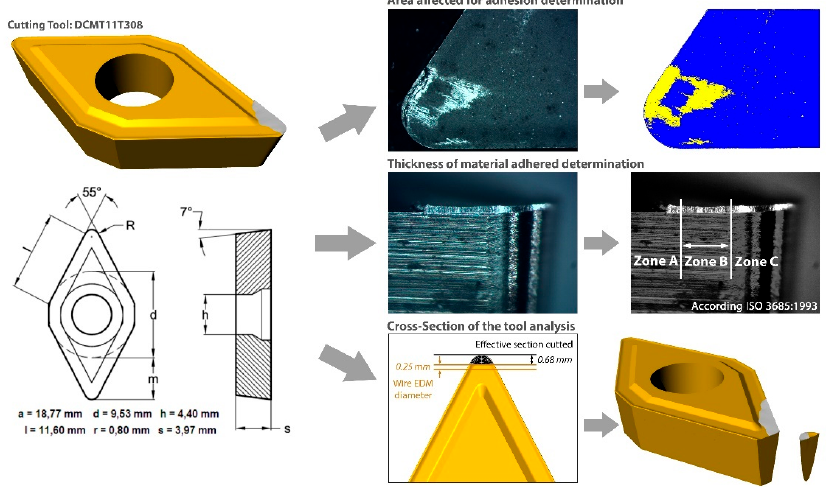
Figure 2. Experimental proposal for adhesion evaluation.